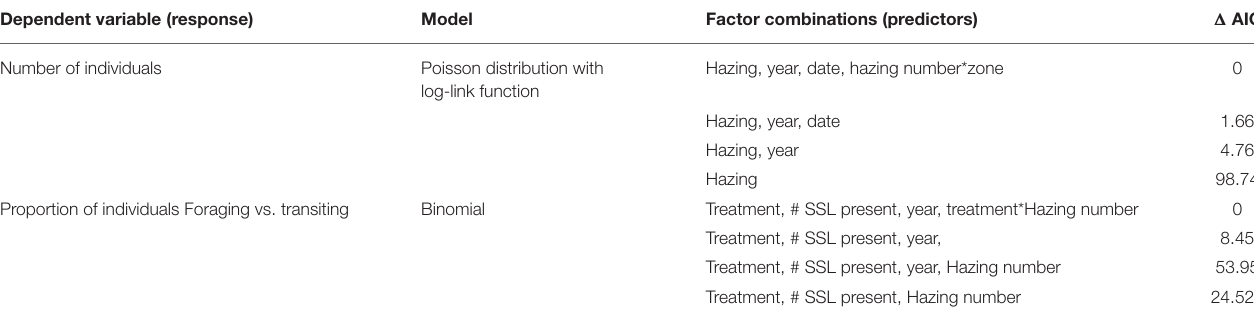
TABLE 2 | Models that were evaluated during model selection.